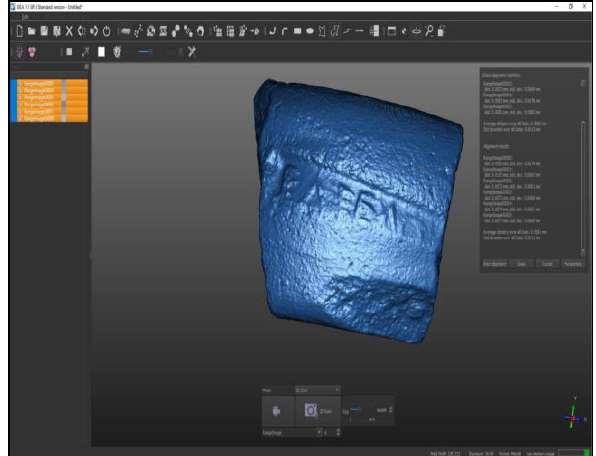
Figure 4 : 3D laser survey of mark No. 63. Global registration for the alignment of the six acquisitions in IDEA software.